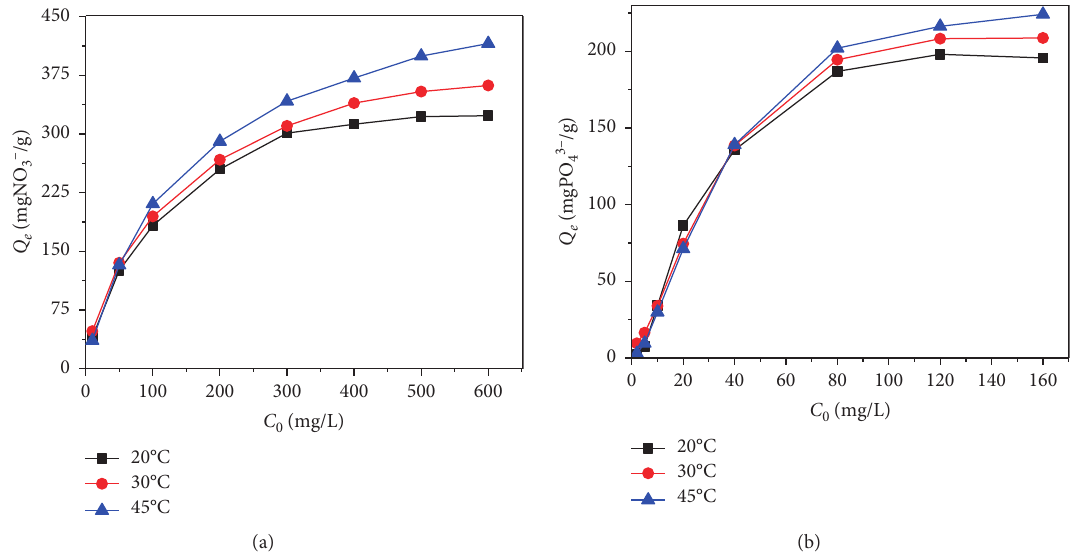
Figure 10: (a) Nitrate and (b) phosphate adsorption capacity of ferric oxide-amine material at different initial concentrations and solution